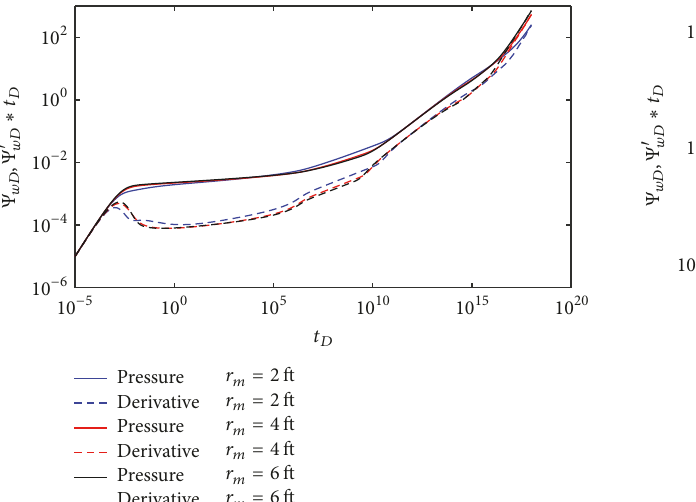
Figure 11: Effect of matrix permeability on pressure.